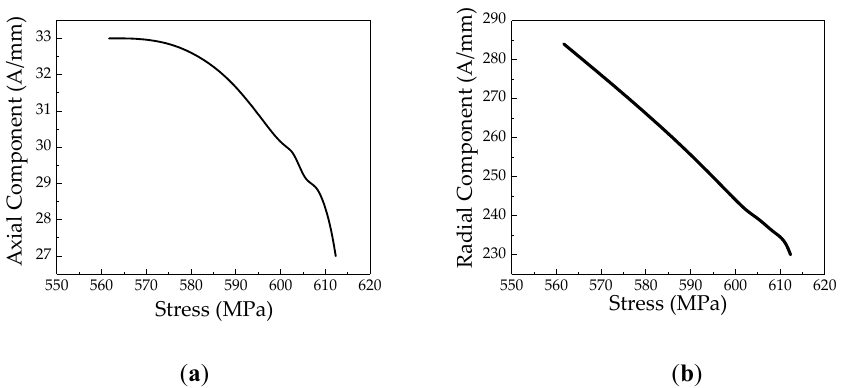
Figure 20. The weak magnetic signal change after the crack expands: ( a ) axial component and ( b ) radial component.